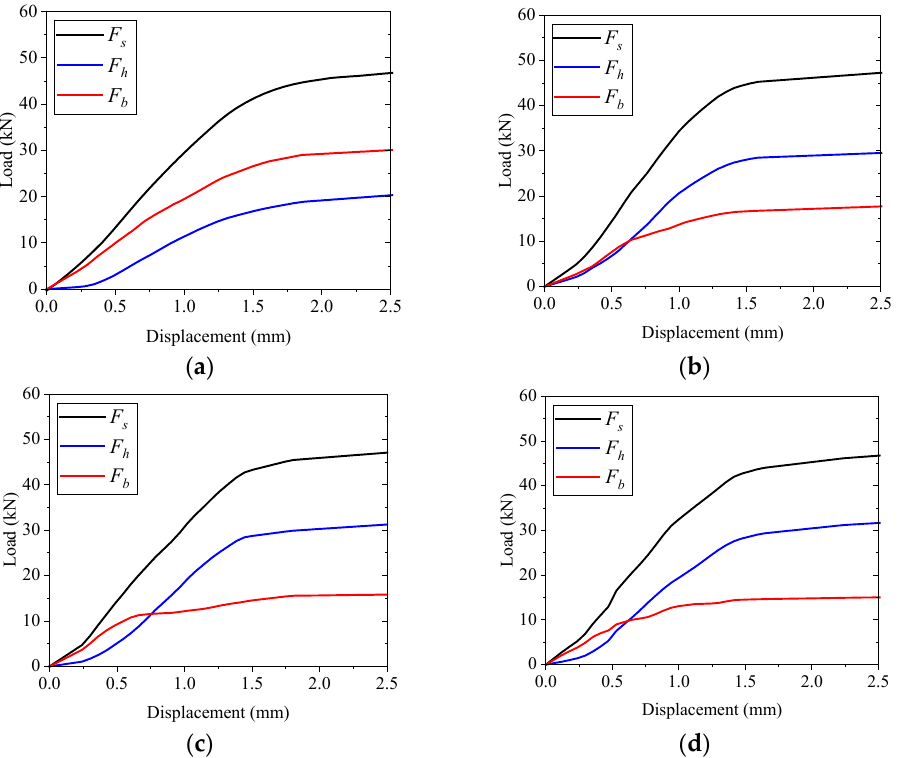
Figure 21. Distribution of headed bar force among specimens with different head size ( a ) Specimen M3-D12-7.5d; ( b ) Specimen M4-D12-7.5d; ( c ) Specimen M6-D12-7.5d; ( d ) Specimen M8-D12-7.5d. The F b / F h values for the yielding of headed bars are shown in Figure 22. In general, the F b / F h values decrease with the increase in the head size, indicating the increase in head size improves the contribution by head bearing. In general, the head-bearing force and the stiffness improve with the increase in head size. Additionally, when the head size is increased by 100% (increasing from 4 A s to 8 A s ), the F b / F h value is decreased by 20.8% and the change in the F b / F h value induced by the change of head size is considerably smaller than that of the lap length. In addition, specimen M3-D12-7.5d shows a remarkable difference compared to other specimens. Similar situations can be seen in Figure 23 in which both the head-bearing response and bond behavior of specimen M3-D12-7.5d are distinct from the other specimens which show a similar response.